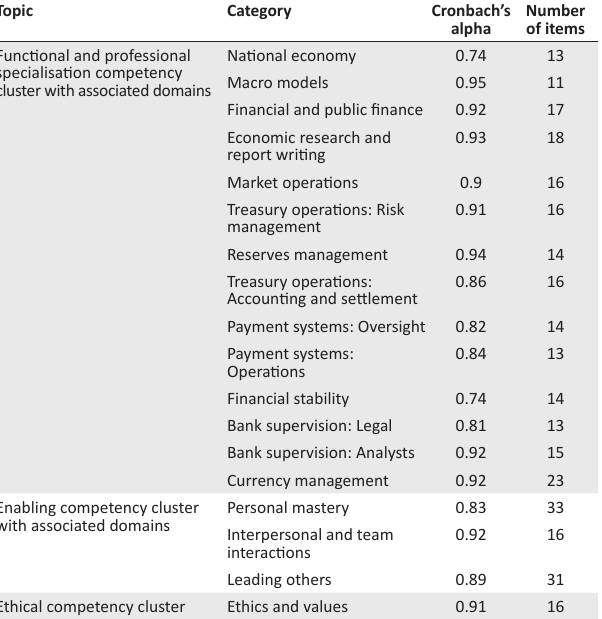
FIGURE 7: Overview of the quantitatively validated GCBCM as constructed by the researchers. TABLE 2: Cronbach’s alpha reliability coefficients of the competency survey